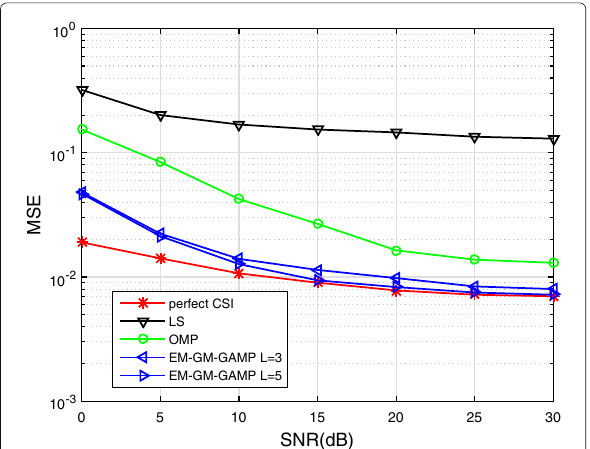
Fig. 1 MSE performance comparison of different algorithms as functions of SNR